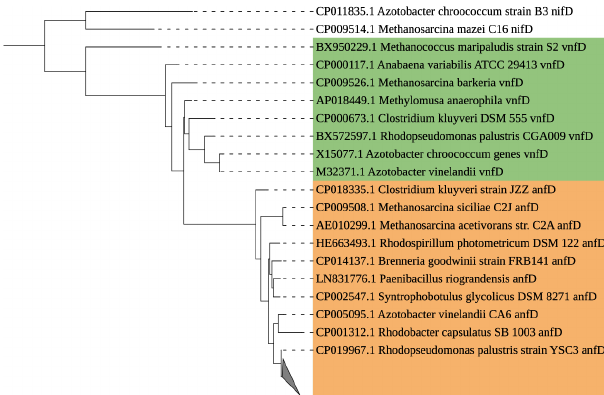
Figure 6. Maximum likelihood tree of anfD/vnfD amplicons (591bp) identified by Sanger sequencing. All recovered sequences clustered with Rhodopseudomonas palustris (grey triangle). The anfD sequences are represented in brown, and vnfD sequences are represented in green. A nifD sequence has been chosen as the out- group.